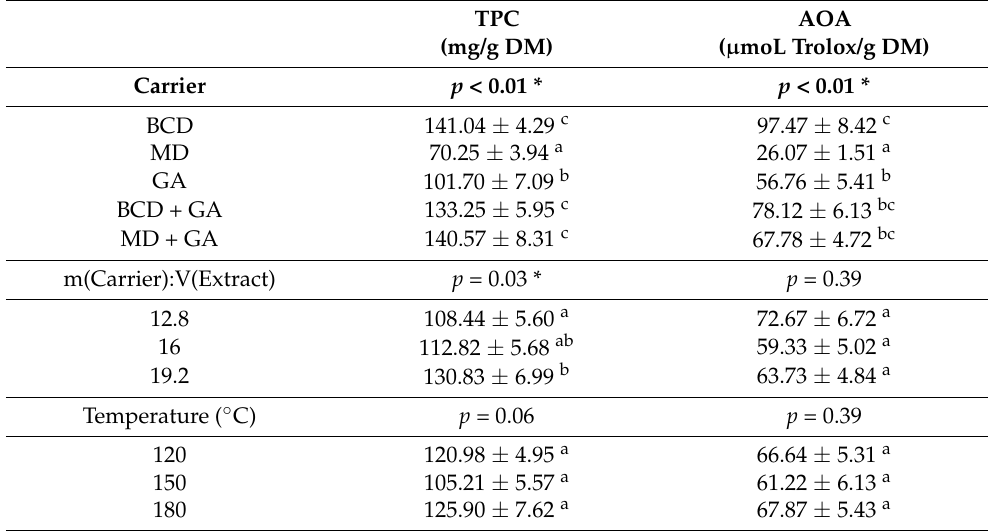
Table 4. Influence of carrier type, carrier concentration and inlet temperature on total phenolic content and antioxidant activity of produced